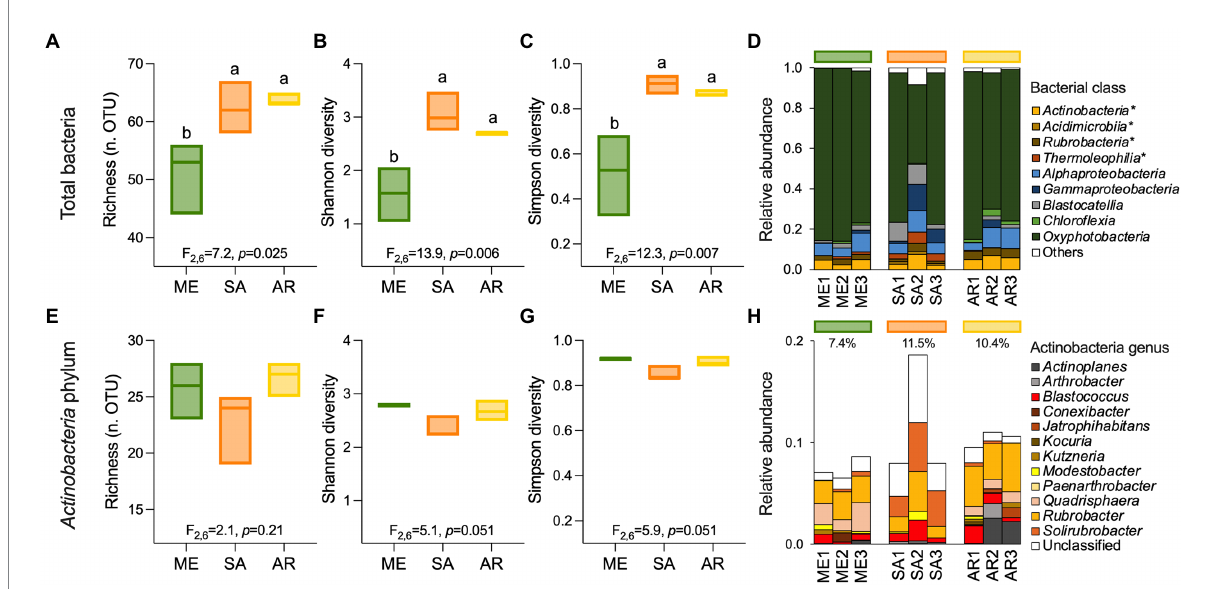
FIGURE 3 Alpha-diversity and composition of ruin stones’ bacterial communities. (A,E) Richness, (B,F) Shannon diversity, and (C,G) Simpson diversity indices for total bacterial communities (99 OTUs) and members of Actinobacteria phylum (37 OTUs) associated with the stones across the aridity transect. (D) Relative abundance of bacterial classes. Star (*) indicates classes belonging to the Actinobacteria phylum and “others” the low abundant groups (relative abundance <1% and non-belonging to Actinobacteria). (H) Relative abundance of genera within the Actinobacteria phylum.